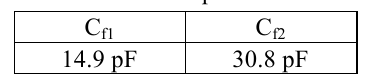
Figure 14: High frequency model of the CM filter As well known, the parameters of the wire (R varying with the frequency. On Figure 15 are given the evolution of the elements R turns around the NiZn ferrite core used as CM filter.